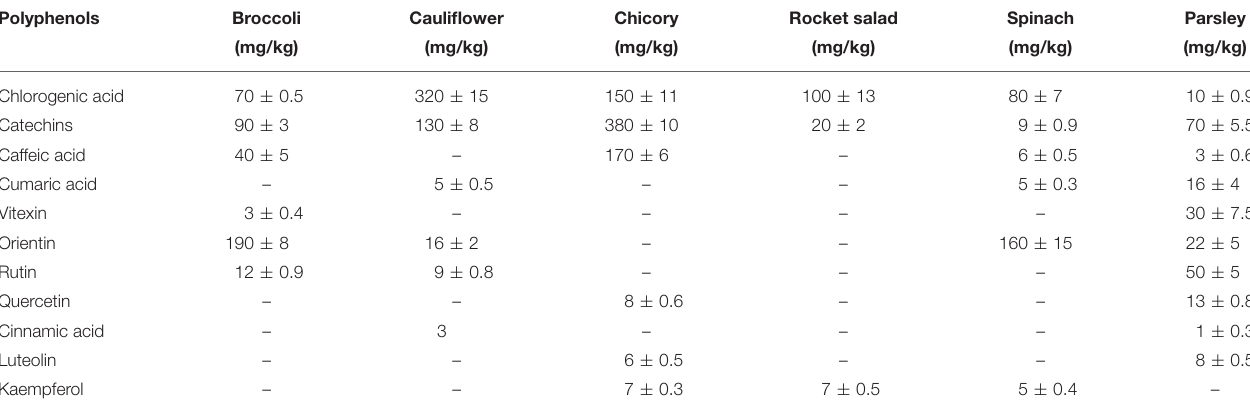
TABLE 1 | Phenolic compounds found in the vegetable extracts, obtained after the extraction process by N.E. following the enzymatic pre-treatment ( n = 3).